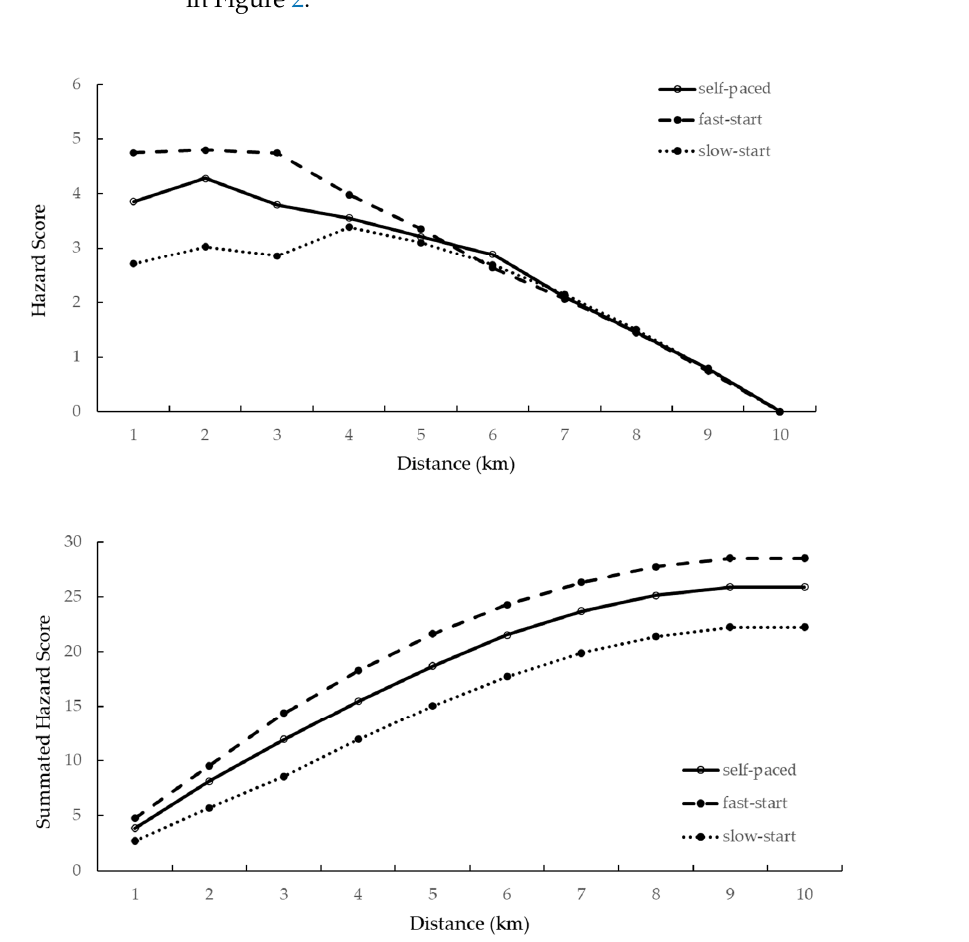
Figure 2. Growth of Hazard Score ( a ) and summated Hazard Score ( b ) in relation to distance during self-paced, fast-start, and slow ‐ start time trials. There was a significant interaction between the starting strategy and the distance covered for HS ( p = 0.022) and summated HS ( p = 0.031). HS during the fast ‐ start TT was significantly greater than the self ‐ paced TT at kilometers 1 and 3. HS during the fast ‐ start TT was significantly greater than the slow ‐ start TT at kilometers 1 and 2. HS during the self ‐ paced TT was significantly greater than the slow ‐ start TT at kilometers 1, 2, and 3 (Table 7). Summated HS during the fast ‐ start TT was significantly greater than the self ‐ paced TT from kilometers 3–10. Summated HS during the fast ‐ start TT was significantly greater than the slow ‐ start trial for kilometers 1–10. Summated HS during the self ‐ paced TT was significantly greater than the slow ‐ start trial for kilometers 2–10 (Table 8). Table 7. Means ± standard deviations of the Hazard Score during self ‐ paced, fast ‐ start, and slow ‐ start time trials. Distance (km)